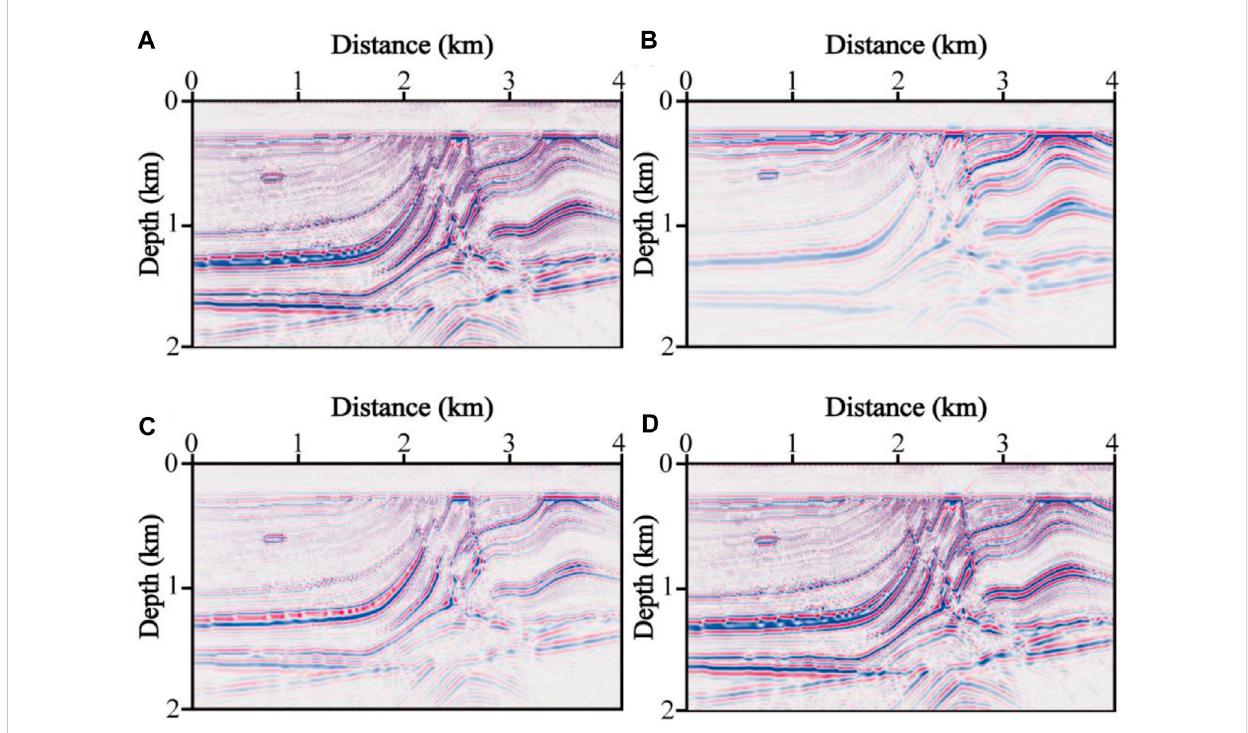
FIGURE 7 Migration results of the Marmousi model. (A) acoustic RTM to acoustic data; (B) acoustic RTM to viscoacoustic data; (C) average Q -compensated RTM; (D) constant-order compensated RTM.